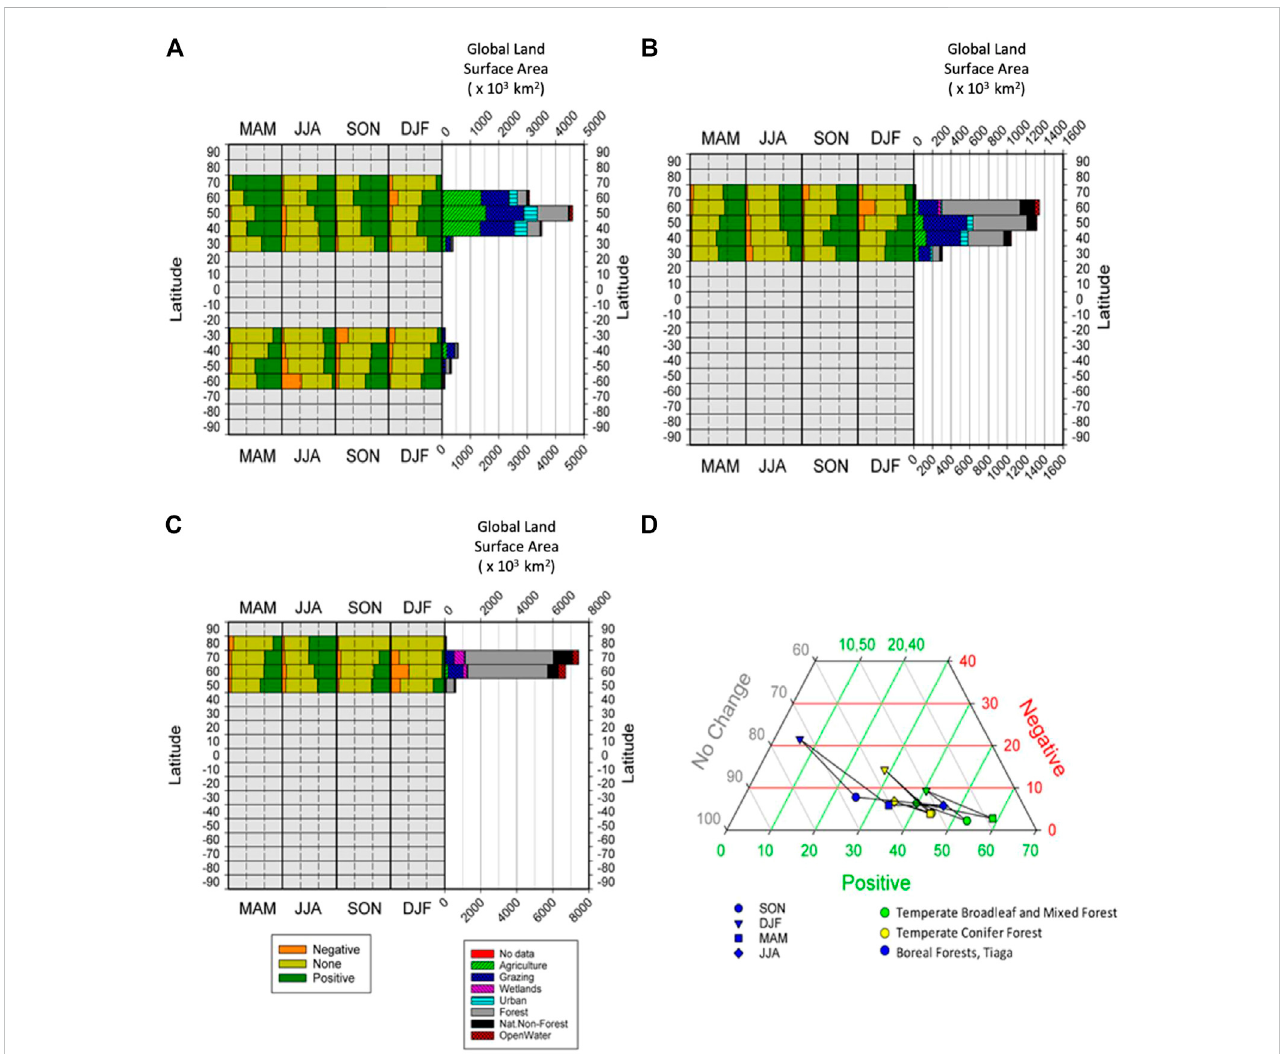
FIGURE 5 Composition of signi fi cant persistence values (Negative, None, Positive) in each biome, broken down by latitudinal band, with land use diversity of each bank also shown, for (A) Temperate Broadleaf Mixed Forest, (B) Temperate Coniferous Forest, (C) Boreal Forest -Taiga, and (D) Ternary plot of the seasonal changes in percentages of global areas returning signi fi cant percentages of positive and negative persistence, and those reporting to signi fi cant persistence, for three non-tropical forest